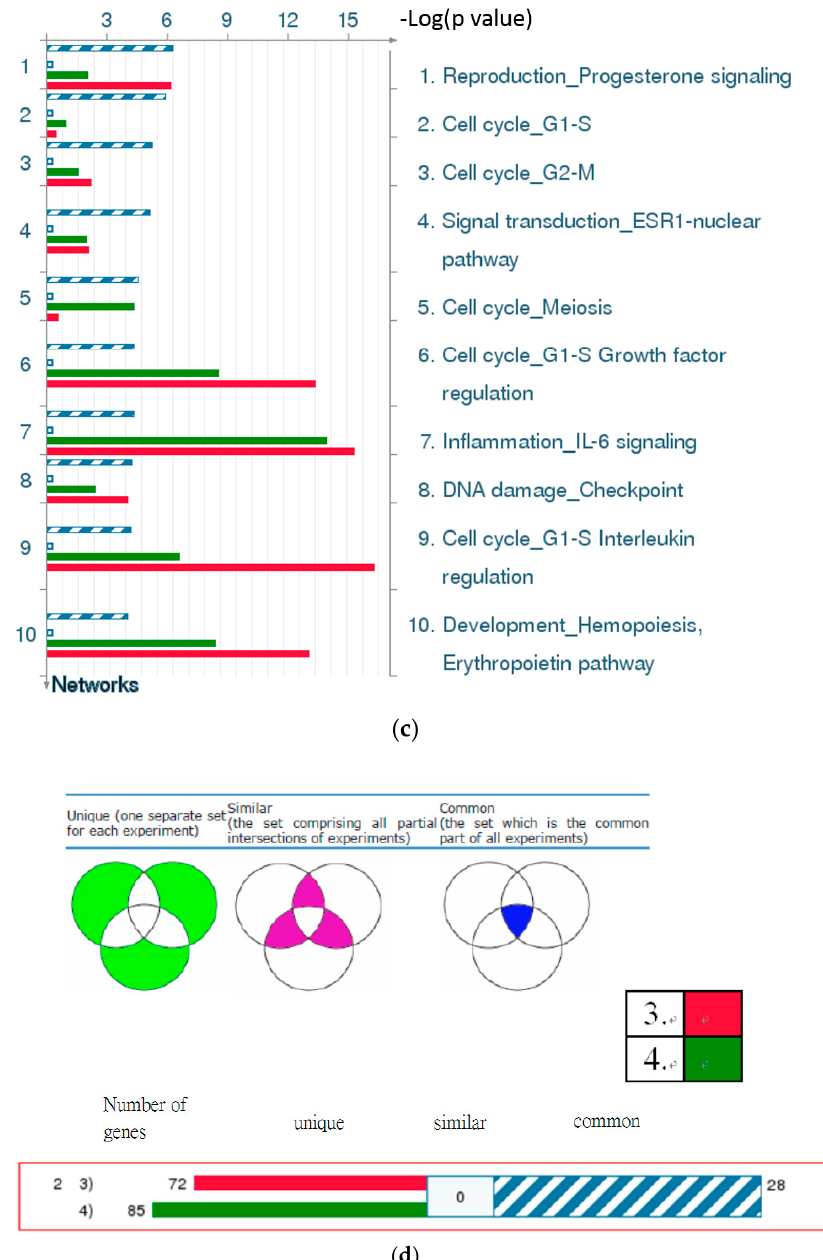
Figure 4. Results of the MetaCore™ analysis for the last two time points post-TBI (24 and 72 h). Results are sorted according to those most strongly represented in the “common” set. ( a ) Pathway maps. Canonical pathway maps represent a set of signaling and metabolic maps that comprehensively cover human biological functioning. All maps are created by Thomson Reuters scientists using a high quality manual curation process based on published peer reviewed literature. Experimental data is visualized on the maps as blue (for down-regulation) and red (up-regulation) histograms. The height of the histogram corresponds to the relative expression value for a particular gene/protein; ( b ) Gene ontology (GO) cellular processes. Since most GO processes have no gene/protein content, the “empty terms” are excluded from p- value calculations; ( c ) Process networks. The content of these cellular and molecular processes is defined and annotated by Thomson Reuters scientists. Each process represents a pre-set network of protein interactions characteristic for the process; ( d ) Figure legend giving the meanings of the colors and statistical interpretation of the above three figures. These figures were generated by MetaCore™.